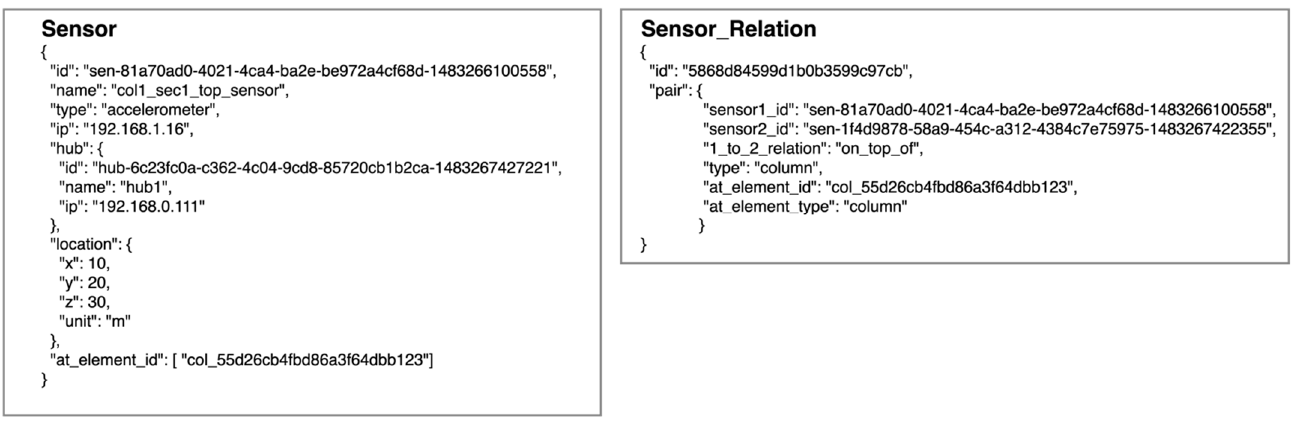
Figure 9. Mapping between sensor device local timestamp and server clock time.